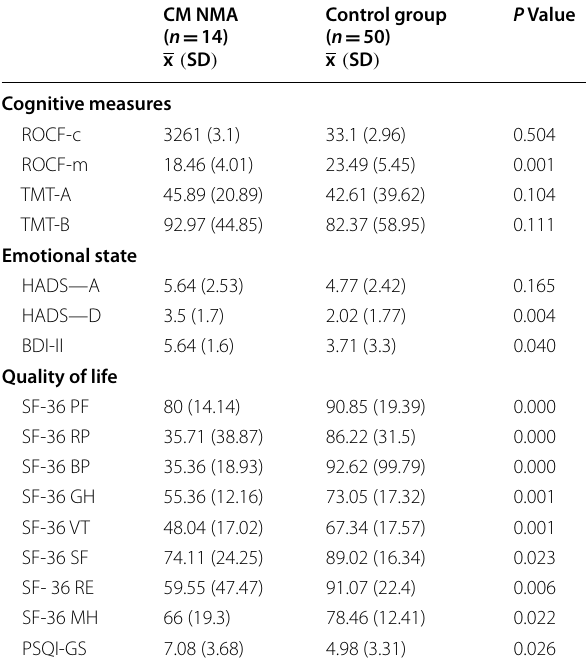
Table 5 Comparison between patients with normal mood in improvement achieved the scores of the controls in the the CM group ( n 14) and the control group ( n 50) at Taylor Figure Test for longitudinal evaluation (Table 6, = = Fig. 6).